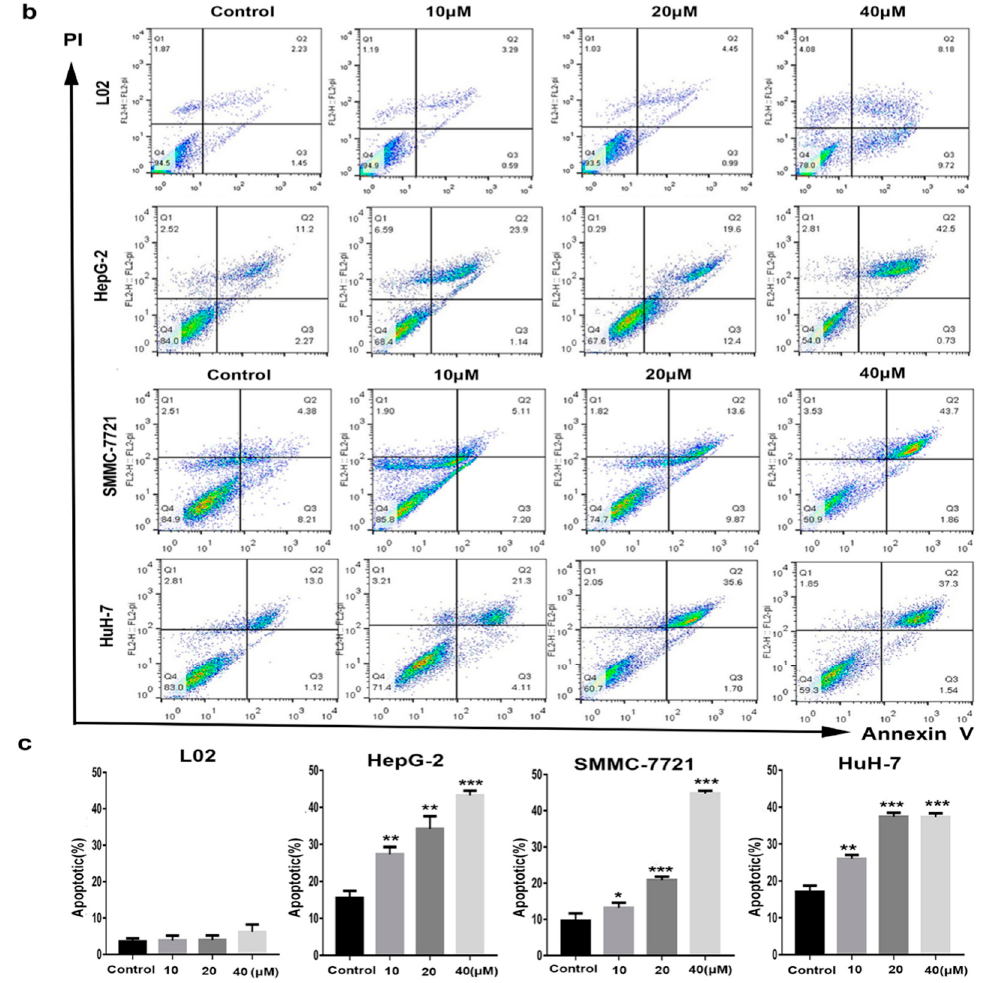
Figure 3. The apoptos is promoting effect of compound 1 . ( a ) The morphological changes in HCC cells and L02 cells. HCC cells and L02 cells were treated by compound 1 with various concentrations (0, 10, 20, and 40 µ M) for 72 h. Apoptosis was evaluated by Hoechst 33342 dye to observe all morphological changes (bar = 100 µ m). ( b ) HCC cells and L02 cells were treated by compound 1 with various concentrations (0, 10, 20 and 40 µ M) for 72 h, and apoptosis effects were evaluated by PI/annexin V staining-based flow cytometry. ( c ) Representative histograms of the total apoptotic rate (% of total). The values are presented as mean ± SD (n = 3): * p < 0.05, ** p < 0.01, *** p < 0.001 compared to the